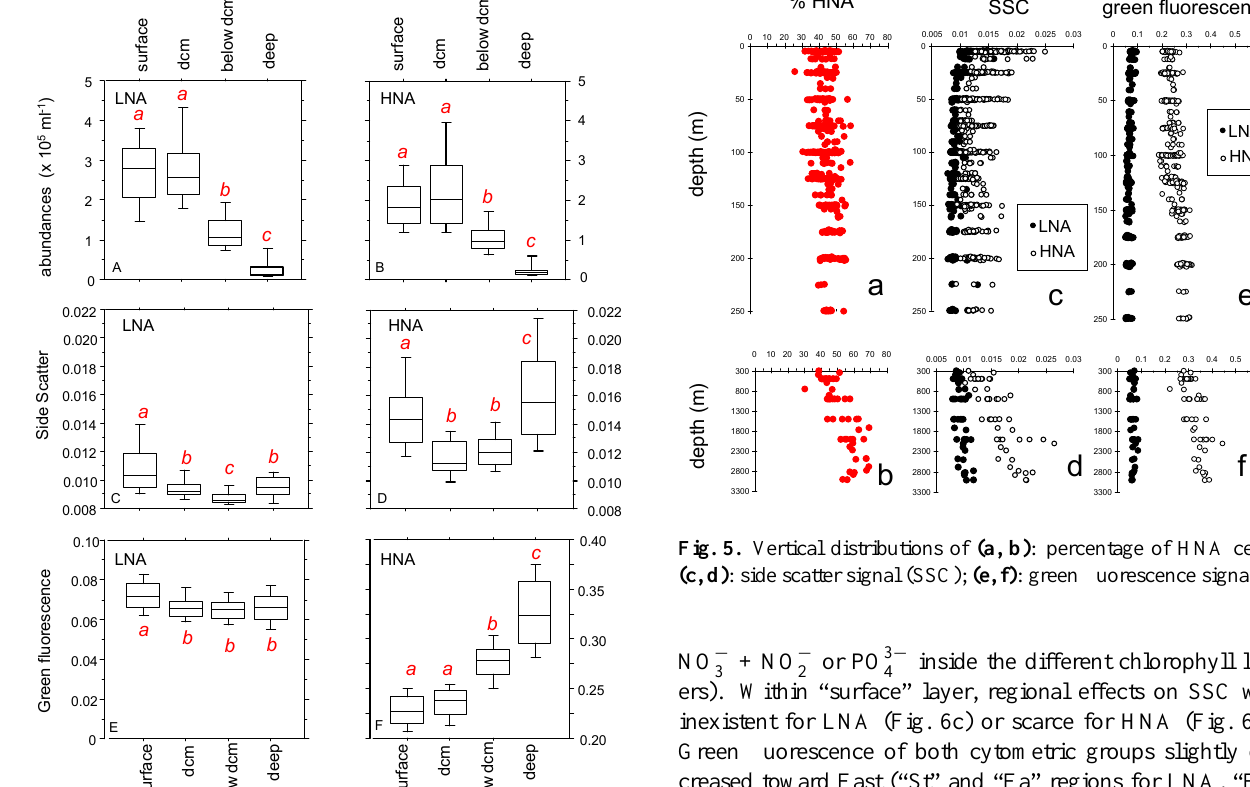
or PO 3 − inside the different chlorophyll lay- NO − + NO − 4 2 3 ers). Within “surface” layer, regional effects on SSC was inexistent for LNA (Fig. 6c) or scarce for HNA (Fig. 6d). Green fluorescence of both cytometric groups slightly de- creased toward East (“St” and “Ea” regions for LNA, “Ea” region for HNA, Fig. 6e,